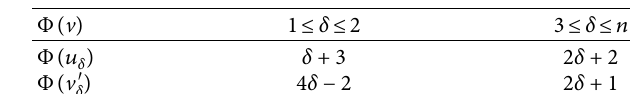
Table 7: Vertex labeling of Φ ( v ).